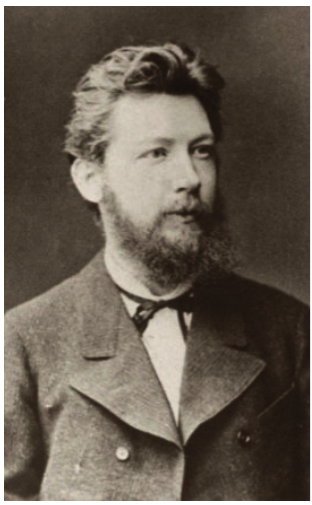
Figure 5. Photo of Wilhelm Ostwald from 1882, the year he became a professor at the Riga Polytechnic. Unknown author. Reprinted with permission. © Copyright Gerda and Klaus Tschira Foundation,